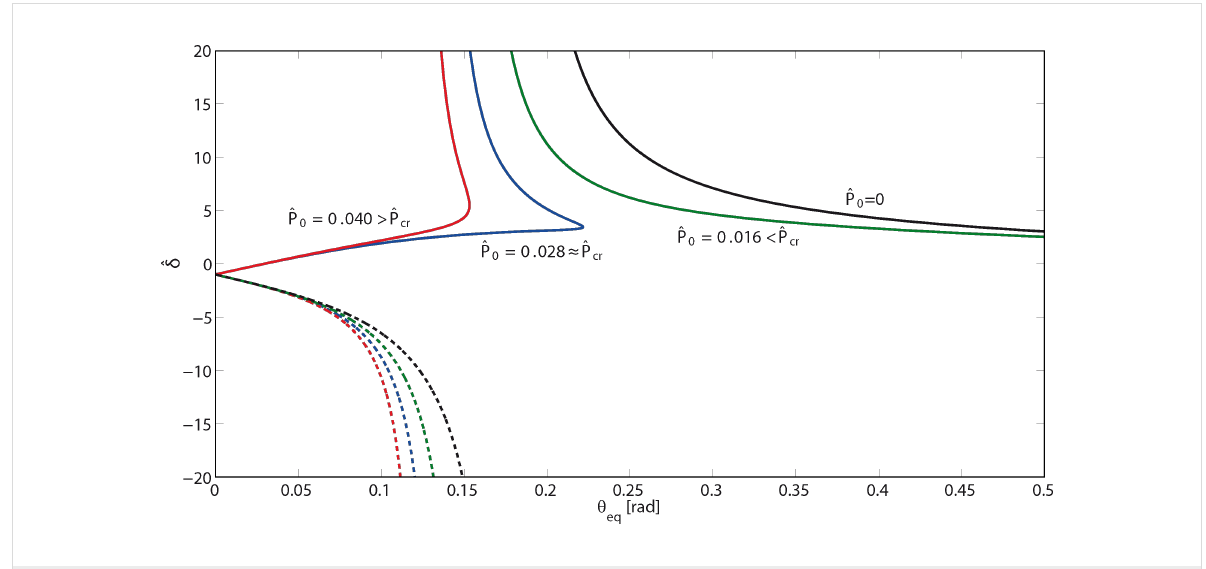
Figure 4: The dimensionless displacement as a function of the peeling angle θ eq at equilibrium, for different values of the dimensionless pre- tension .